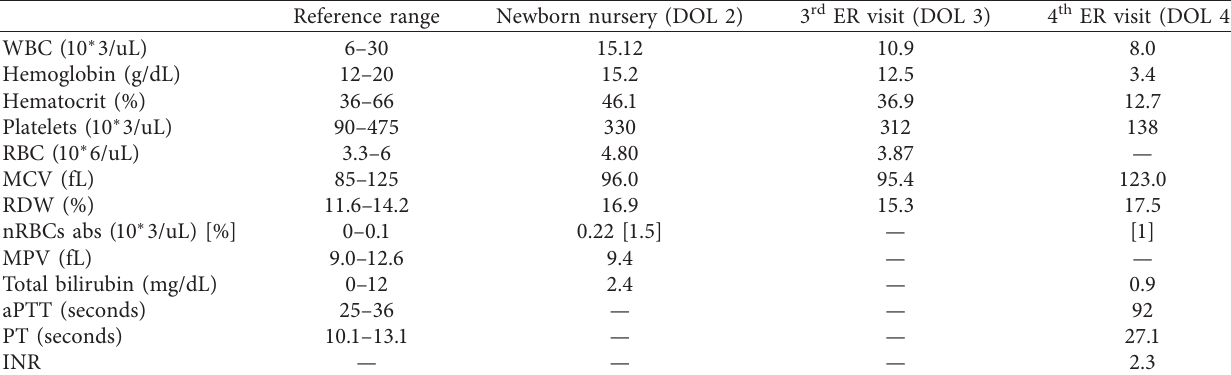
Table 2: Laboratory